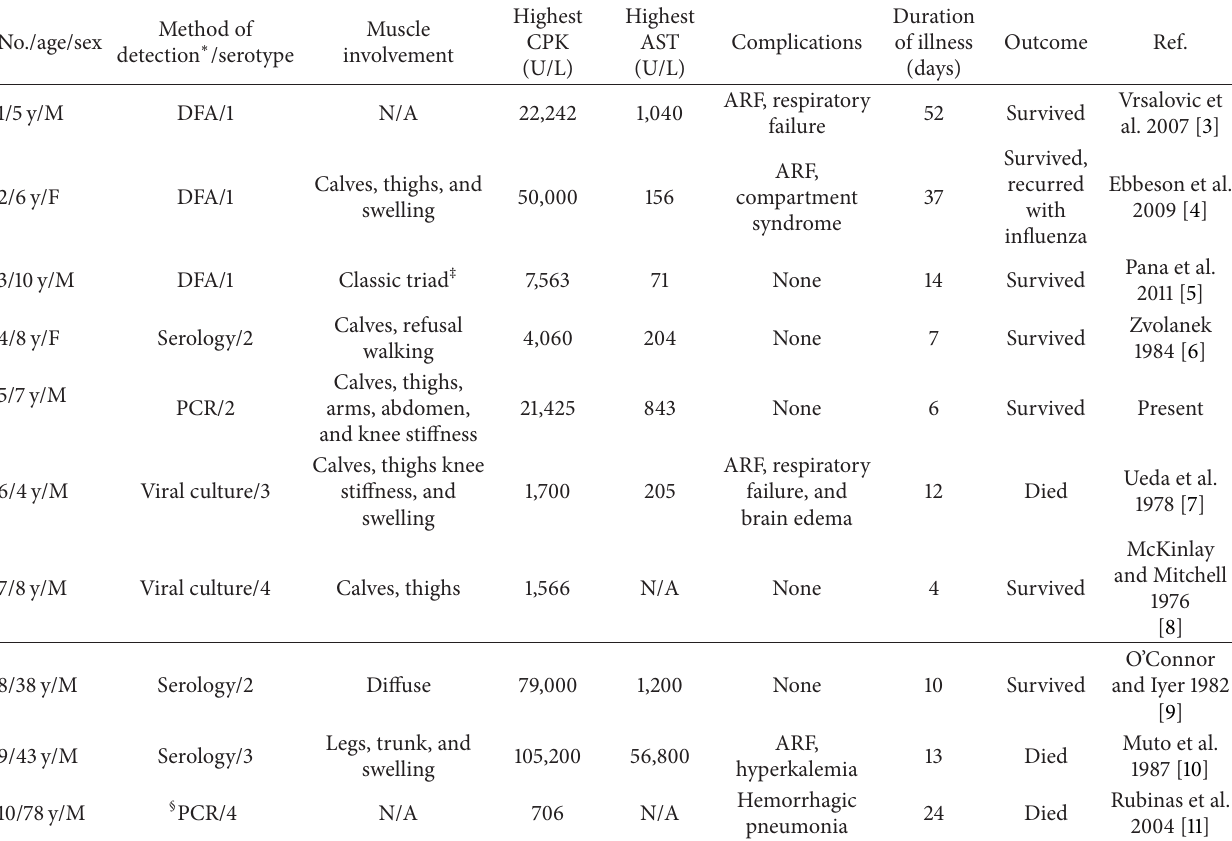
Table 1: Characteristics of reported patients with rhabdomyolysis associated with parainfluenza